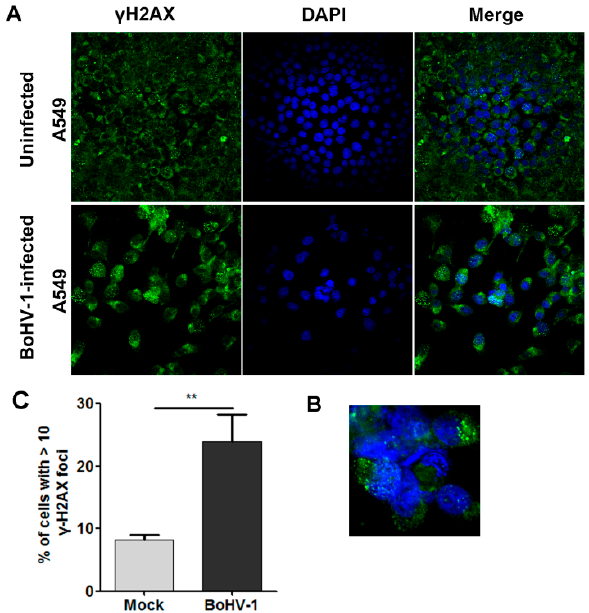
Figure 2. Assessment of γ H2AX foci formation as an indicator of BoHV-1-induced DNA damage in A549 cells. ( A ) A549 cells were either mock-infected or infected with BoHV-1 at an MOI of 0.1 for 24 h. After washing three times with PBS, cells were fixed with 4% formaldehyde, and γ H2AX was detected by IFA. Nuclei were stained with DAPI. Images were obtained by performing confocal microscopy (magnification × 600 with 2.5 zoom). ( B ) Representative cells with γ H2AX localized at the cytoplasm. ( C ) The percentage of cells with ≥ 10 foci within an individual cell was calculated with over 600 cells counted. The error bars denote the variability between the three independent experiments. Significance was assessed with Student’s t -test (** p <